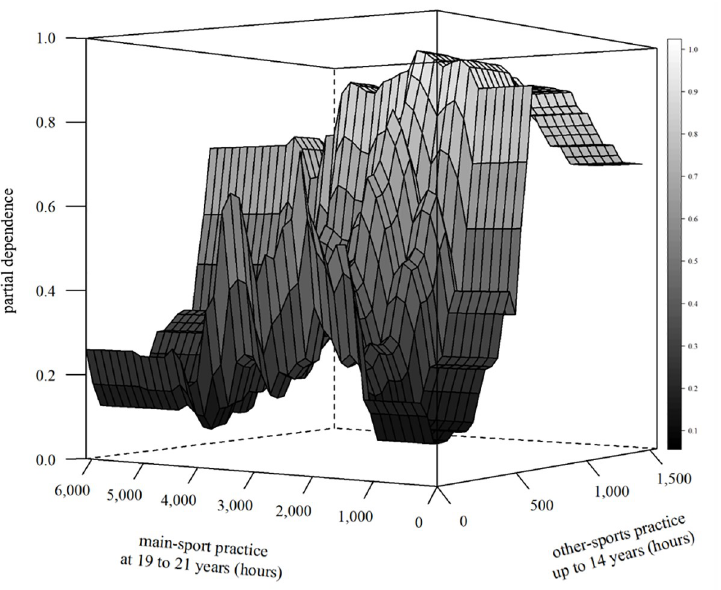
Fig 3. Interactive effect of the features coach-led other-sports practice up to 14 years and coach-led main-sport practice at 19 to 21 years on the probability to be classified as an international medallist. A partial dependence value of 0.5 corresponds to chance. Note the different scale orientations of the